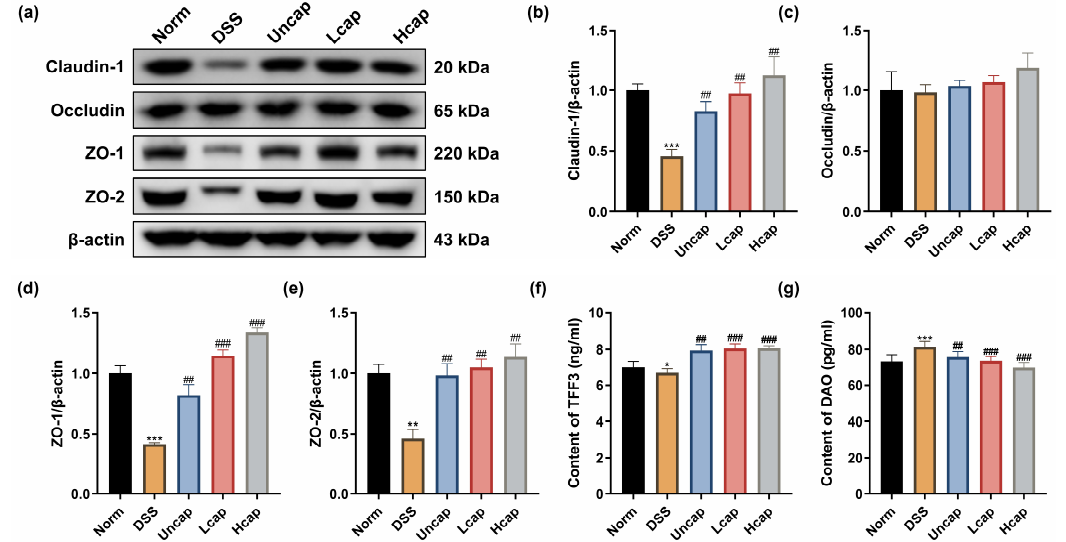
Figure 2. S. spongiosa polysaccharides reduced disruption of intestinal barrier integrity in colitis mice. ( a ) The protein abundances of Claudin-1, Occludin, ZO-1 and ZO-2 were estimated by Western blotting analysis. ( b ) The normalization of Claudin-1 to β -actin. ( c ) The normalization of Occludin to β -actin. ( d ) The normalization of ZO-1 to β -actin. ( e ) The normalization of ZO-2 to β -actin. ( f ) The concentration of TFF3 was measured by ELISA. ( g ) The concentration of DAO was measured by ELISA. The values are reported as means ± SD ( n = 4). * p < 0.05, ** p < 0.01 and *** p < 0.001 vs. Norm group; ## p < 0.01 and ### p < 0.001 vs. DSS group.